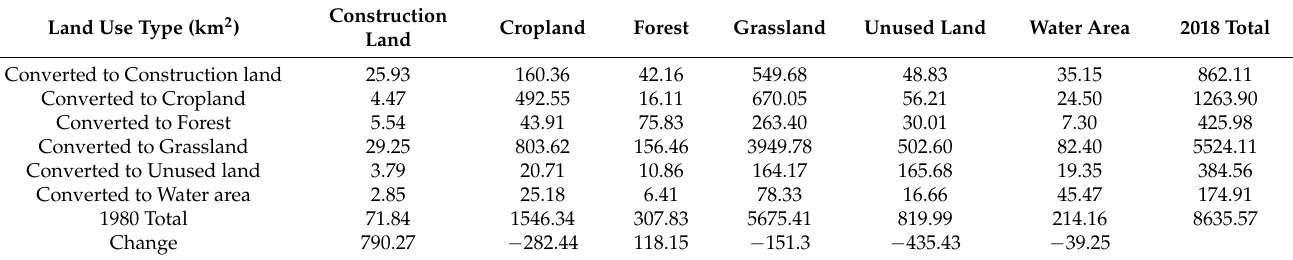
Table 7. Land use transfer matrix for